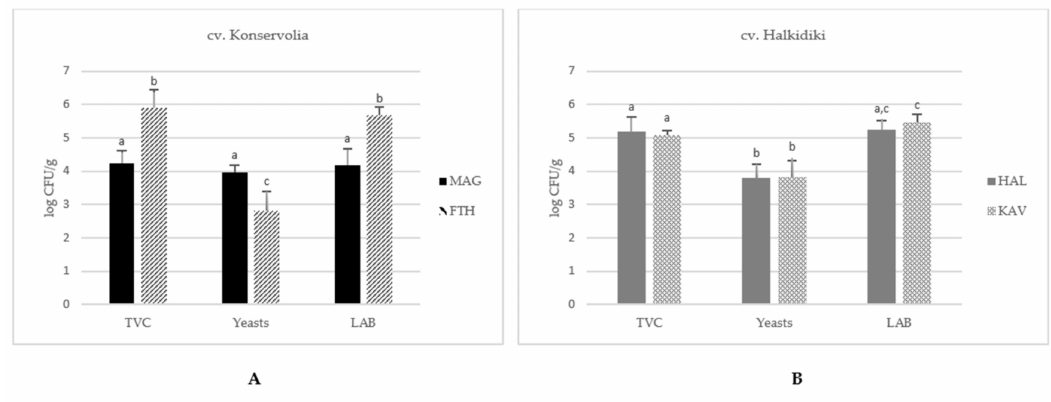
Figure 1. Microbial enumerations of total viable counts (TVC), lactic acid bacteria (LAB), and yeasts in fermented table olives of ( A ) cv. Konservolia from Magnesia (MAG) and Fthiotida (FTH) regions and ( B ) cv. Halkidiki from Kavala (KAV) and Halkidiki (HAL) regions. The results present average values ± SD. Di ff erent letters indicate statistically significant di ff erences ( p < 0.05).